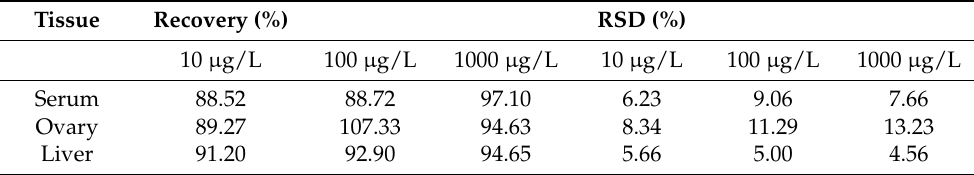
Table 3. Recoveries and RSDs of TTX, including spiked serum, ovary and liver samples.